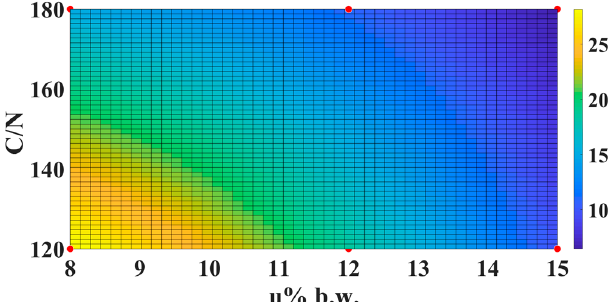
Figure 13. Response surface for diesel oil removal by microcosms with C/N = 120 and C/N = 180 at t = 35 days.